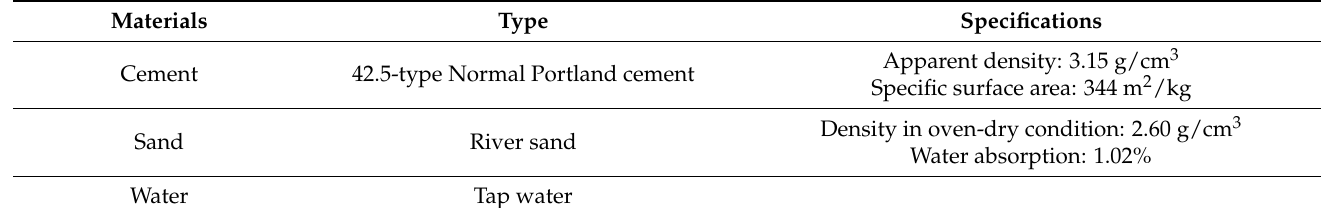
Table 4. List of materials used.